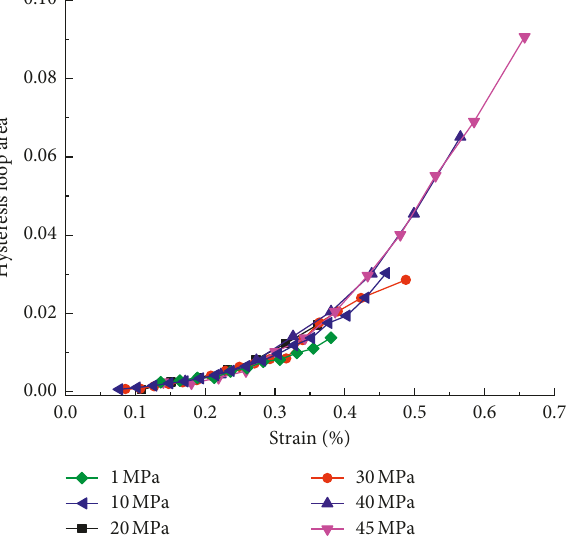
Figure 11: Variation of hysteresis loop